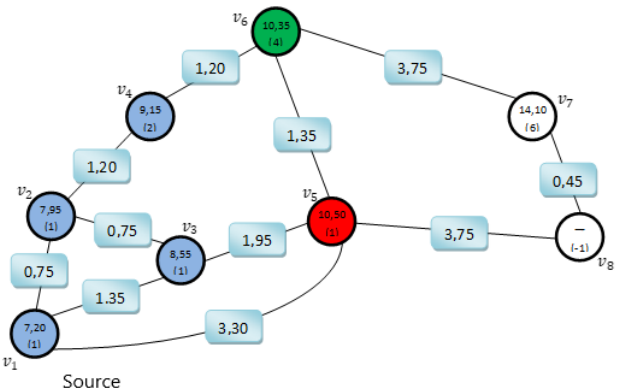
Figure 8. Finding the optimal path from peak 1—step 5.